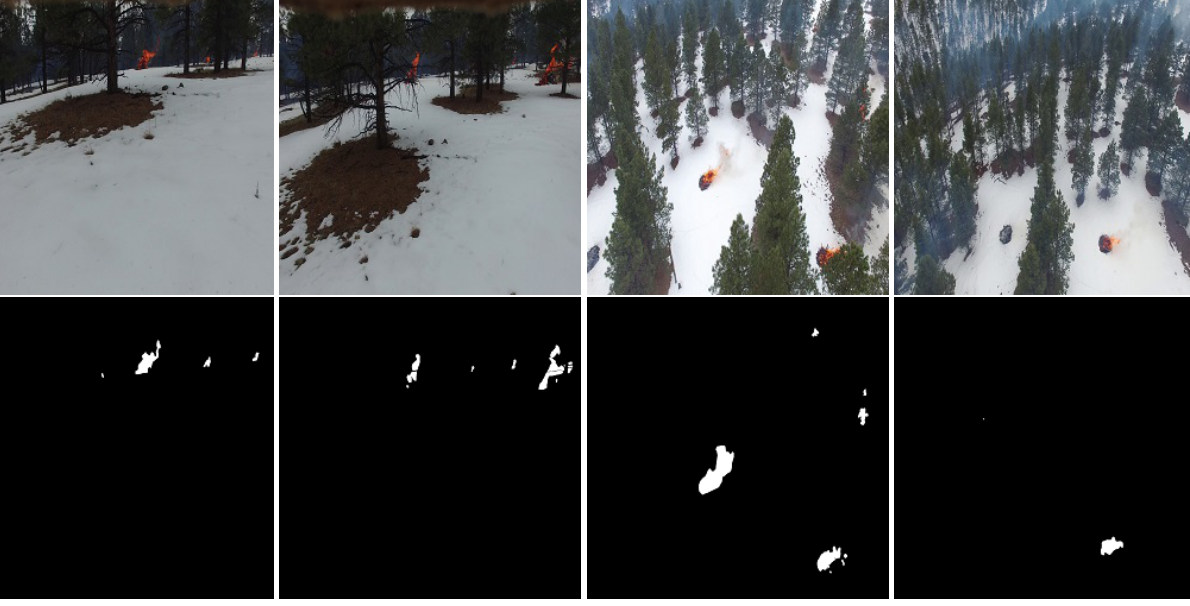
Figure 6. Examples from the FLAME dataset. Top line: RGB images; bottom line: their corresponding binary